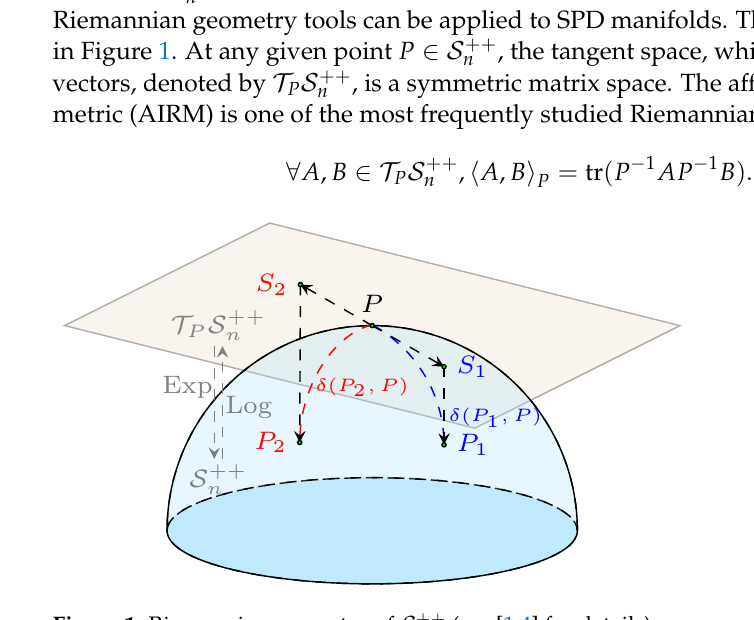
Figure 1. Riemannian geometry of